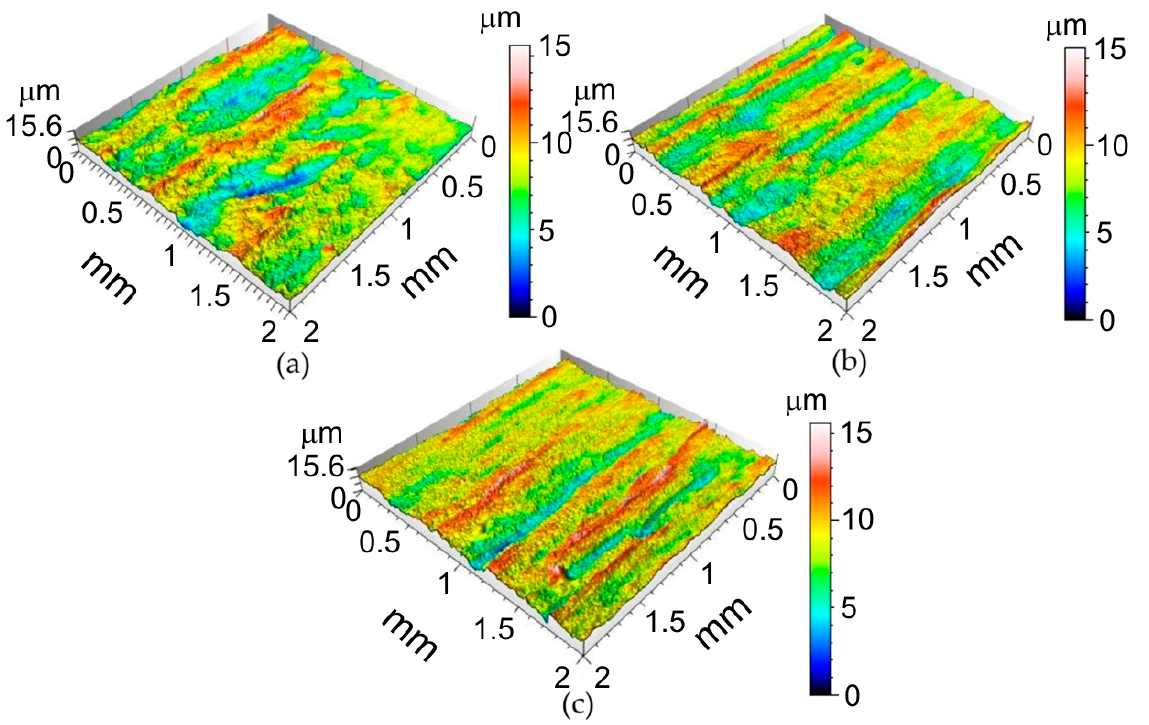
Figure 5. Surface topographies of the inner surface of ribs formed in 0.8-mm-thick EN AW-7075-T6 Alclad fabricated with the following conditions: ( a ) a p = 0.4 mm, v = 18 rpm; ( b ) a p = 0.4 mm, v = 202 rpm; ( c ) a p = 0.2 mm, v = 202 rpm.